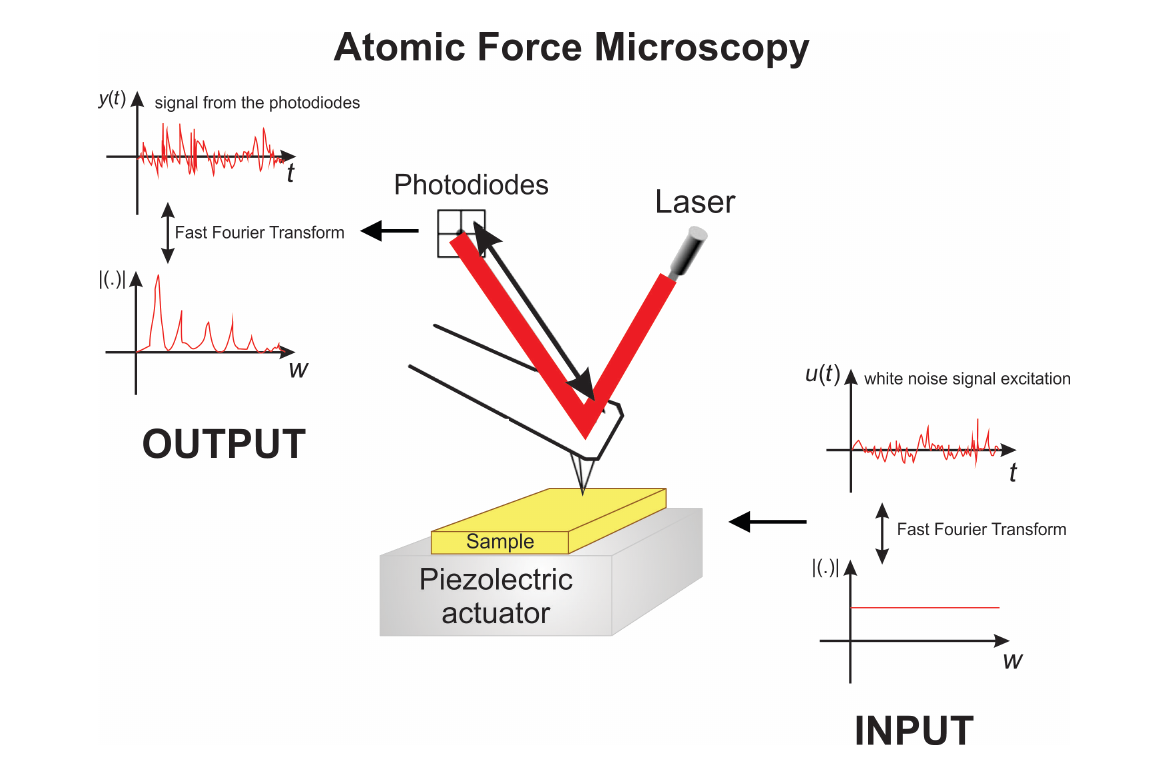
Figure 3: AFM system, the piezoelectrical signal excitation is considered to be the input, while the deflection signal from the photodiodes is consid- ered to be the output.